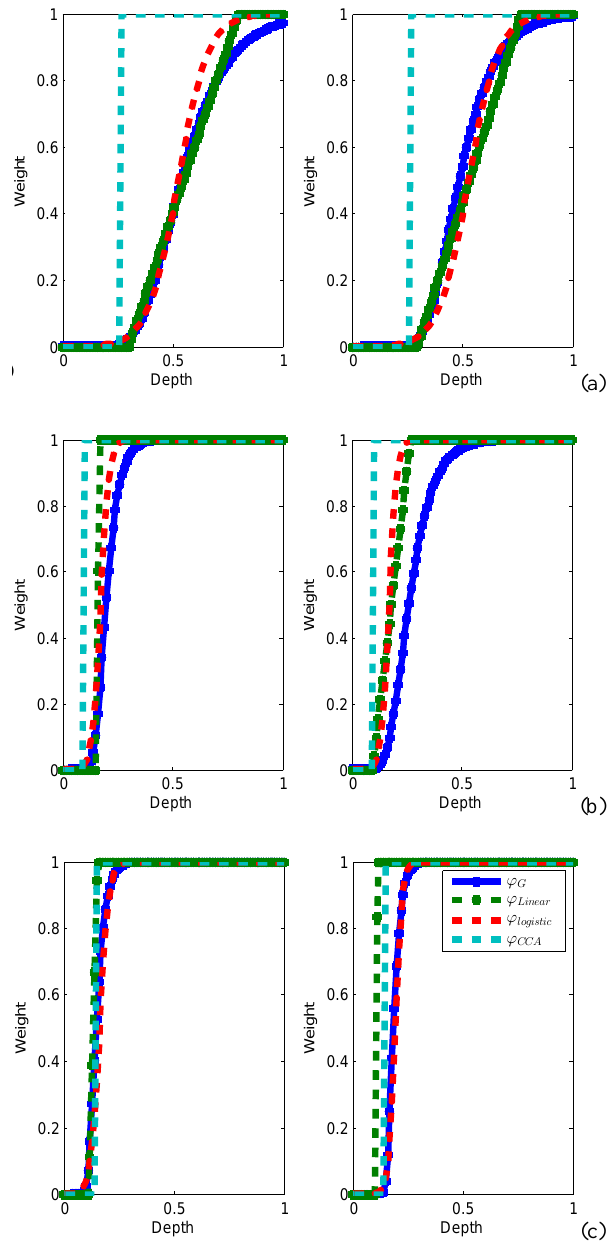
Fig. 5. Optimal weight functions for (a) southern Quebec, (b) Arkansas and (c) Texas. The first column illustrates the weight function’s optimal with respect to RRMSE and the second column illustrates the weight function’s optimal with respect to